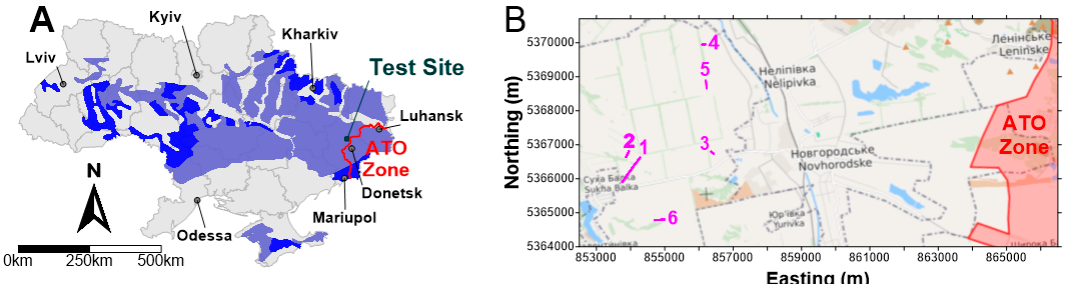
Figure 1. ( A ) Chernozems soils of Ukraine and study site. ( B ) Survey transects and Anti-Terrorist Operations Zone (ATO) zone.